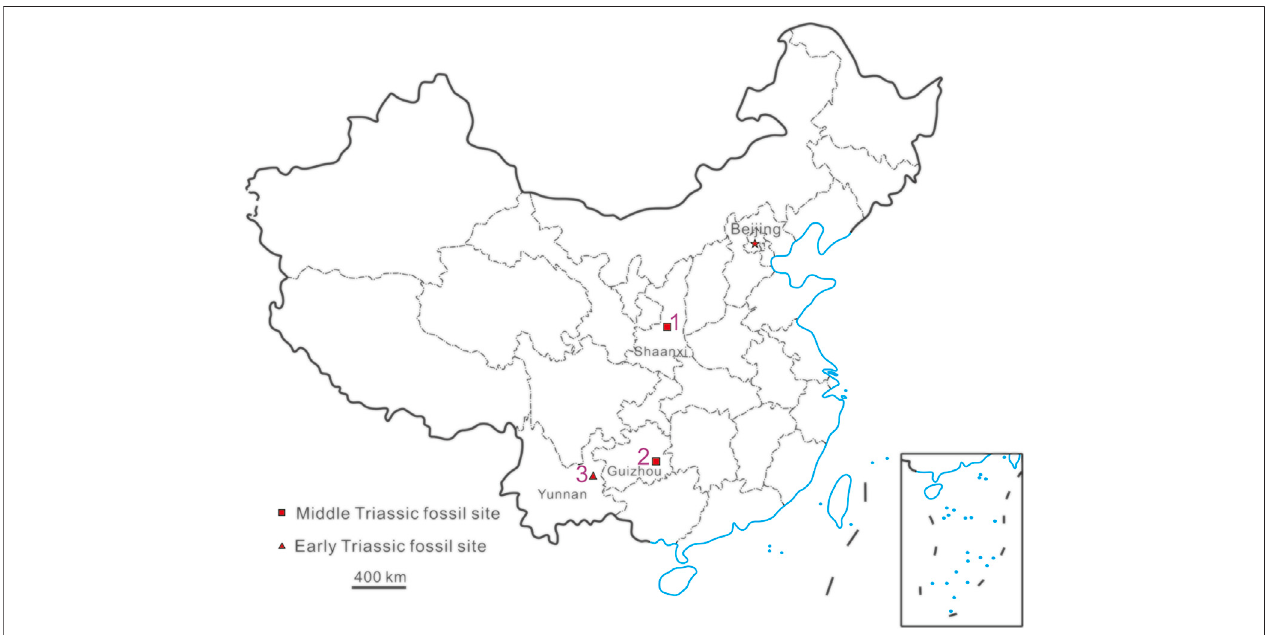
FIGURE 1 | Geographical map showing the distributions of the Triassic Chaulioditidae in China. 1, Tongchuan City, Shaanxi Province; 2, Taijiang County, Guizhou Province; 3, Fuyuan County, Yunnan Province.